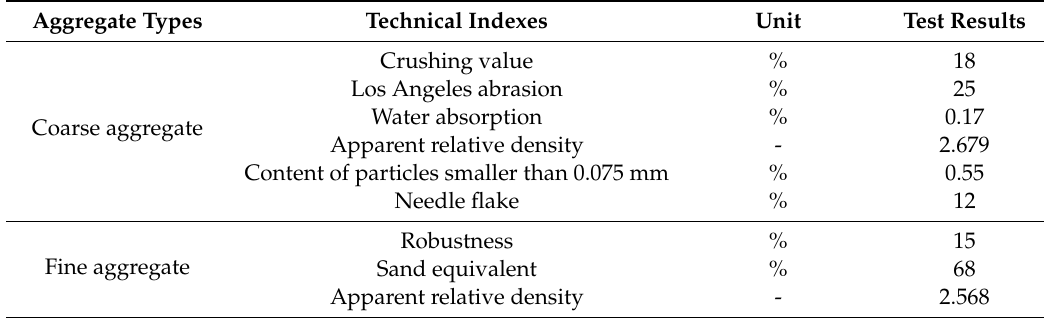
Table 2. Technical indexes of the